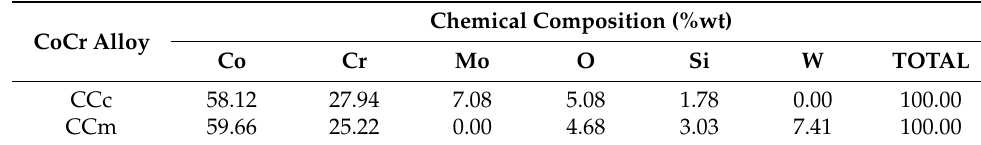
Table 2. Chemical composition obtained by EDS of the Co-Cr alloys.